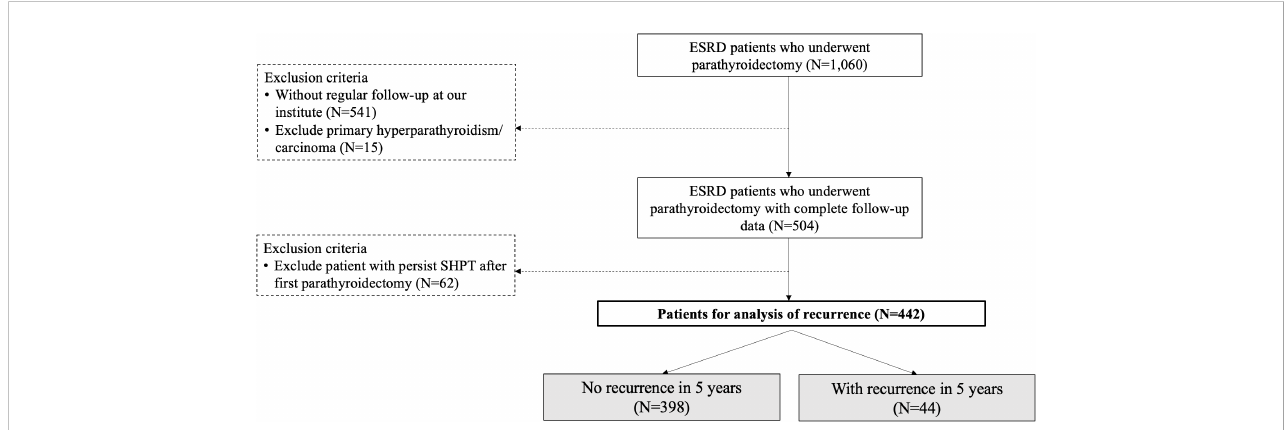
FIGURE 1 Flowchart for the strati fi cation of the study cohort. ESRD, end-stage renal disease; SHPT, secondary hyperparathyroidism. The study period was January, 2011 to June, 2020.